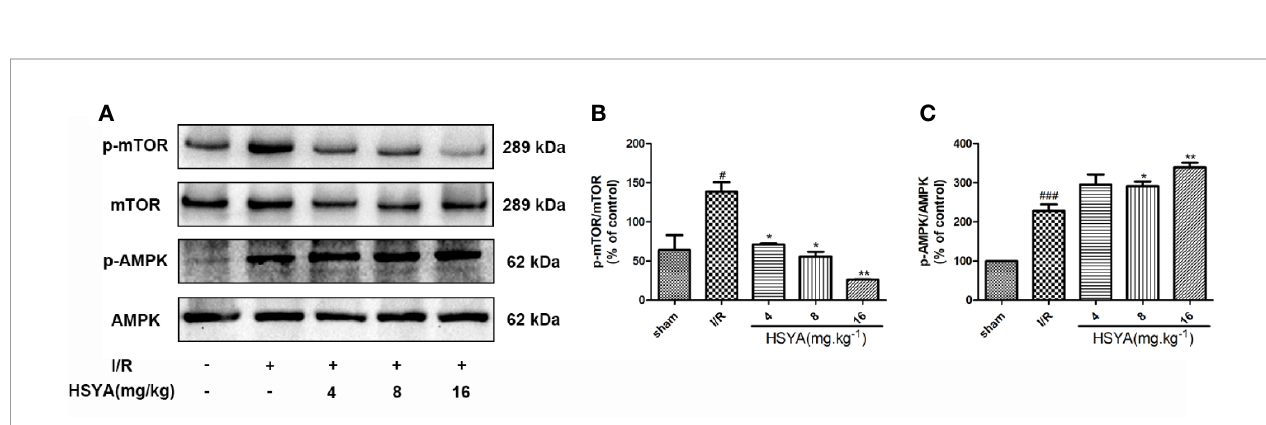
FIGURE 6 | Hydroxysaf fl or yellow A (HSYA) attenuates myocardial ischemia/reperfusion injury by regulating the AMPK/mTOR pathway. (A) Protein expression levels of p-AMPK, AMPK, p-mTOR, and mTOR in heart tissues were assayed by western blot analysis. (B, C) Quanti fi cation of protein expression. Data are presented as means ± SEM. # P < 0.05, ### P < 0.001 vs . the sham group, *P < 0.05, **P < 0.01 vs . the ischemia/reperfusion (I/R)